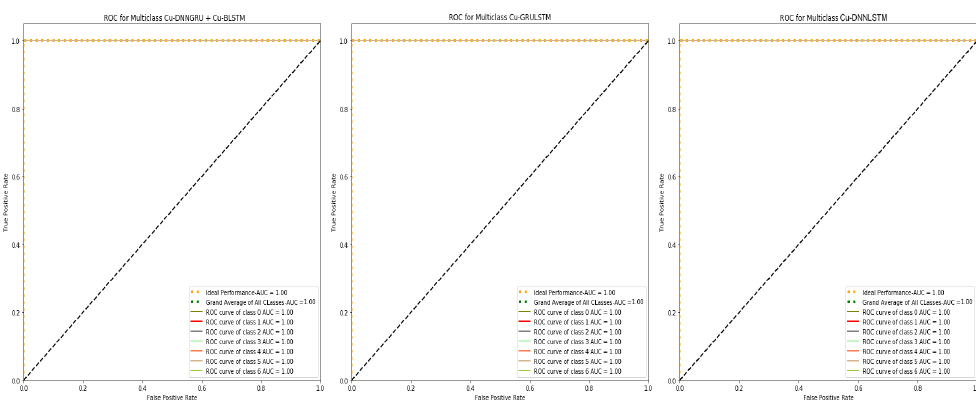
Figure 4. ROC Curves of Cu-DNNGRU + Cu-BLSTM, Cu-GRULSTM, Cu-DNNLSTM.